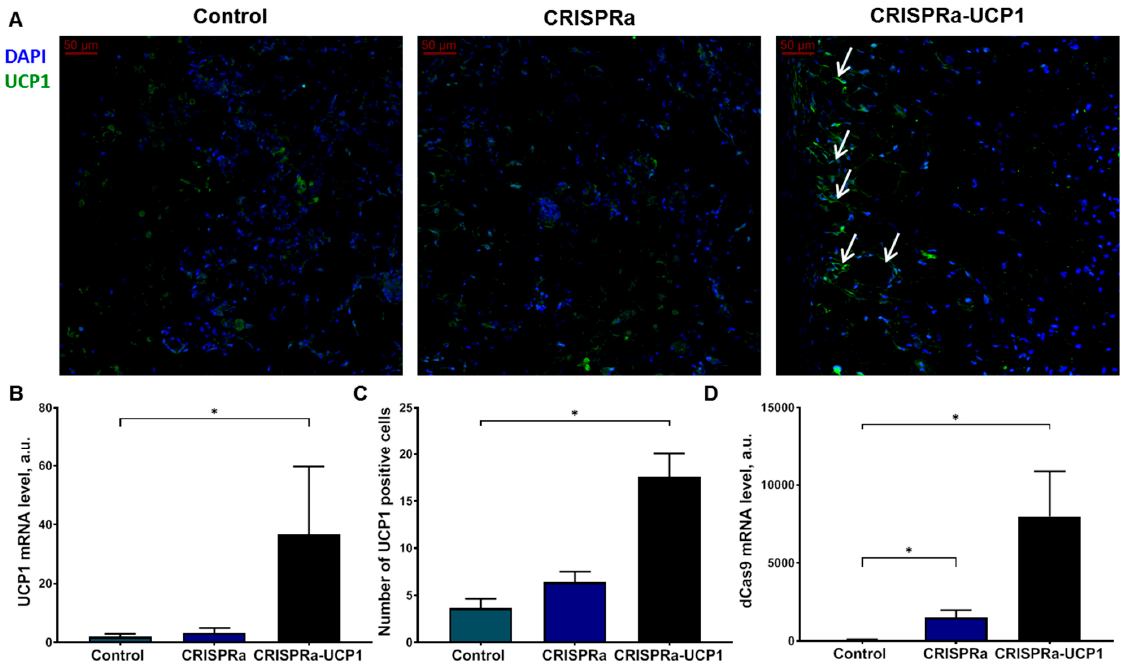
Figure 2. CRISPRa-UCP1 increases the number of UCP1-positive transplanted adipocytes. ( A ) Representative images of Matrigel sections stained for UCP1 and DAPI; ( B ) quantification of UCP1 mRNA in grafts; ( C ) quantification of UCP1-positive adipocytes in graft sections; ( D ) quantification of dCas9 mRNA in grafts. DAPI—4 ′ ,6-diamidino-2-phenylindole; UCP1—uncoupling protein 1. Data are represented as mean ± SEM, Kruskel–Wallis test with post-hoc Dunn’s test, *—significance threshold p < 0.05.